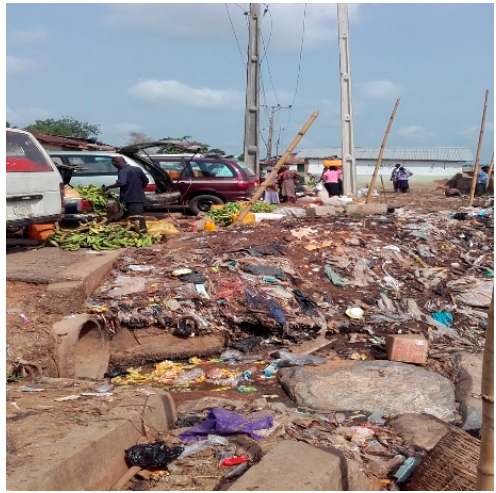
Figure 4. Showing the trashed waterway beside the carpark.